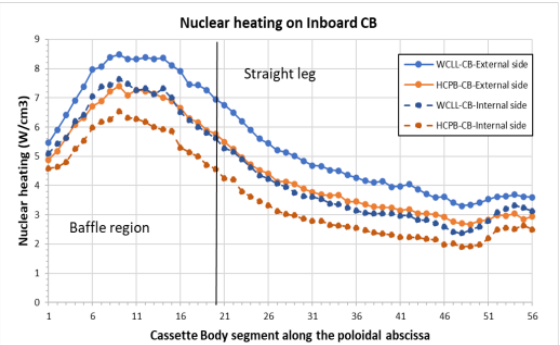
Figure 51. Inner poloidal profiles of the nuclear heating (W/cm 3 ) on the first CB layer made of Eurofer, comparing the values on the external and the innermost sides, both for WCLL and HCPB blanket case.